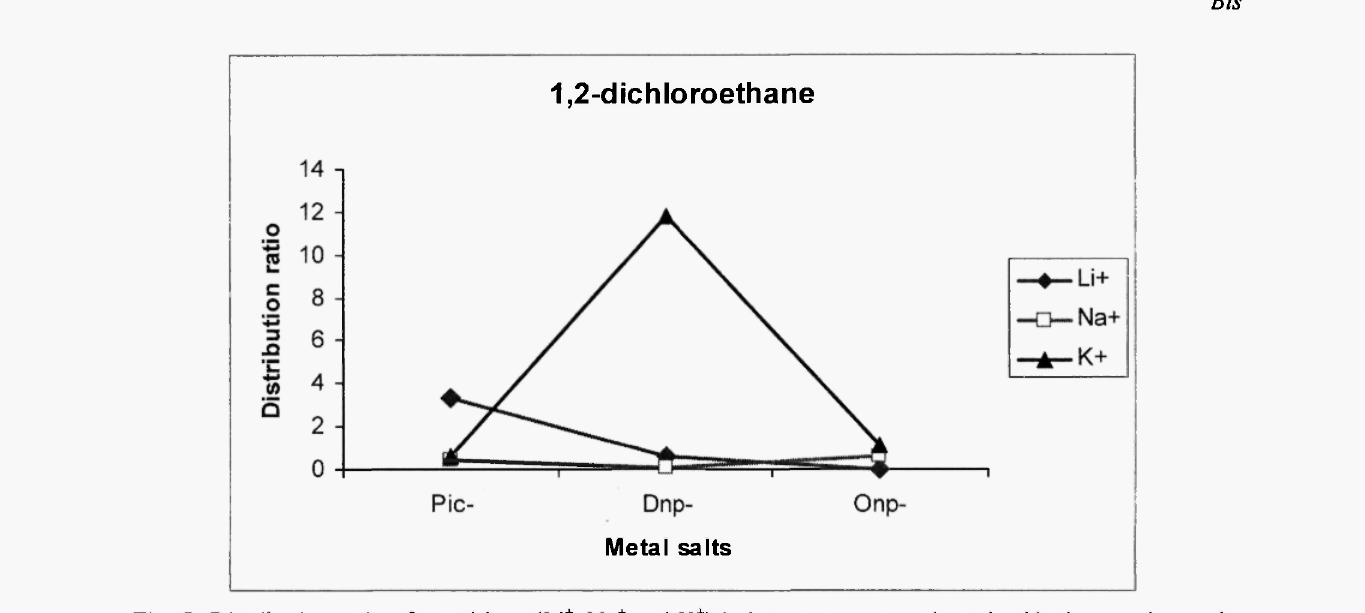
Fig. 5: Distribution ratio of metal ions (Li + , Na + and K + ) in between aqueous (metal salt) phase and organic phase (1,2-dichloroethane) using Triethyleneglycol bis(2-ethylhexanoate) after 4 hrs.; Aqueous